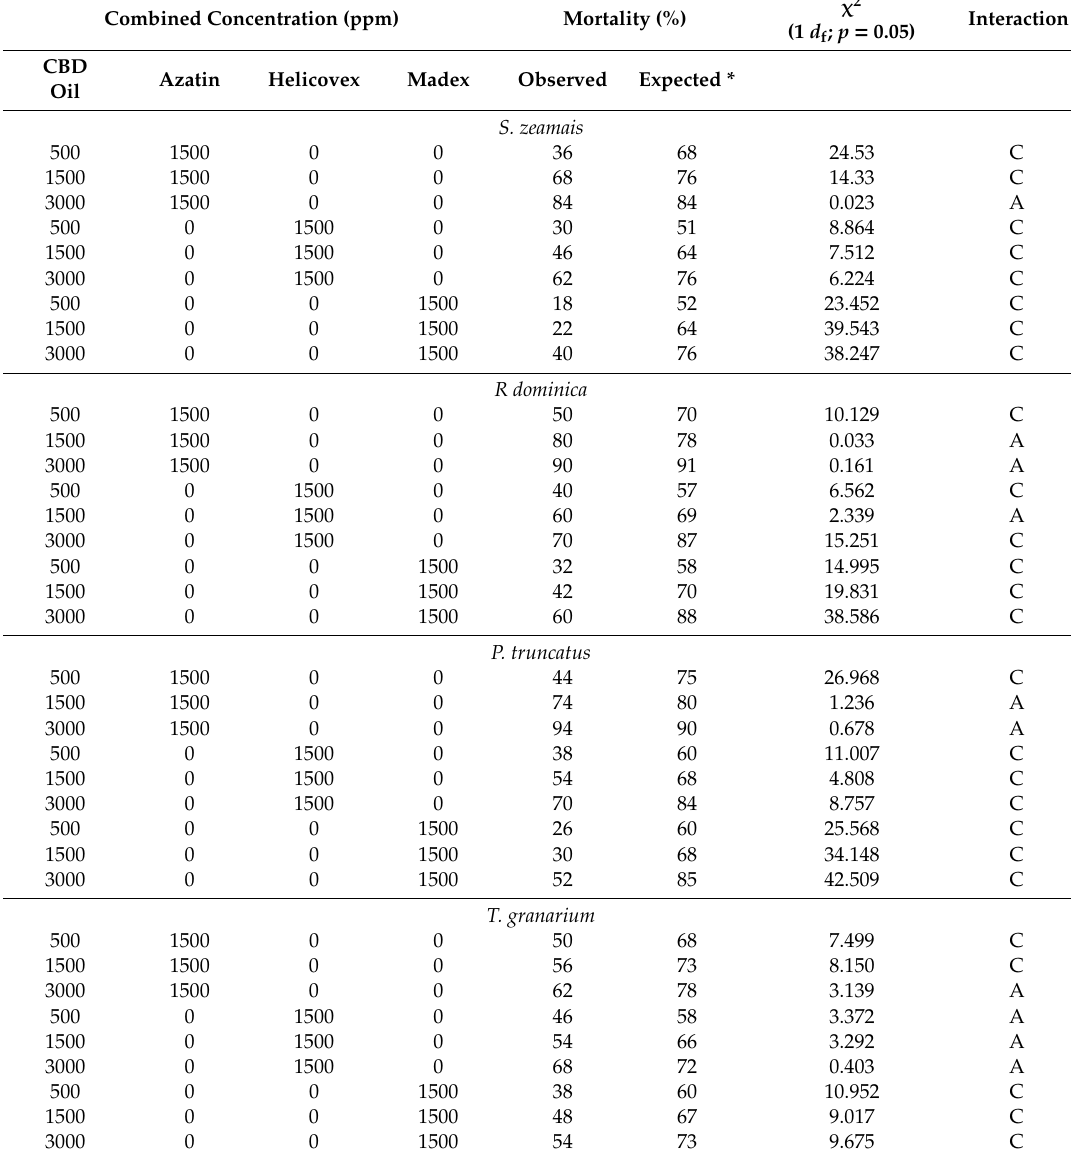
Table 3. Observed and expected mortality of S. zeamais , R. dominica , P. truncatus and T. granarium adults at the end of the experiment (28 days) treated with CBD oil in combinations with Azatin, Helicovex and Madex, plus their interaction (A = Additive. C = Competitive. S = Synergistic) ( n = 200). * Expected mortality is calculated according to Robertson and Preisler